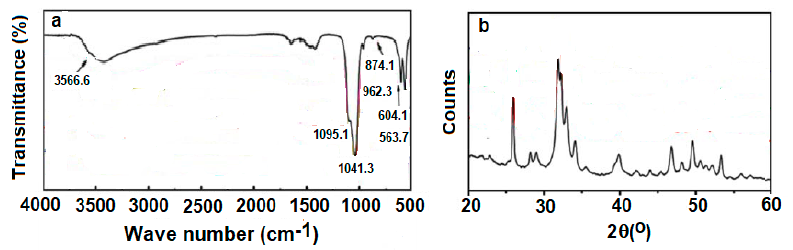
Figure 1. Structure characterization of nHA by FT − IR ( a ) and XRD ( b ) analyses. Similarly, the presence of characteristic diffraction peaks in the X-ray diffraction (XRD) spectrum (Figure 1b) of nHA at 25.87 o (002), 31.81 o (211), 32.17 o (112), 32.86 o (300), 34.04 o (202), 39.85 o (310), 46.74 o (222), 49.50 o (213) and 53.24 o (004) are found useful to